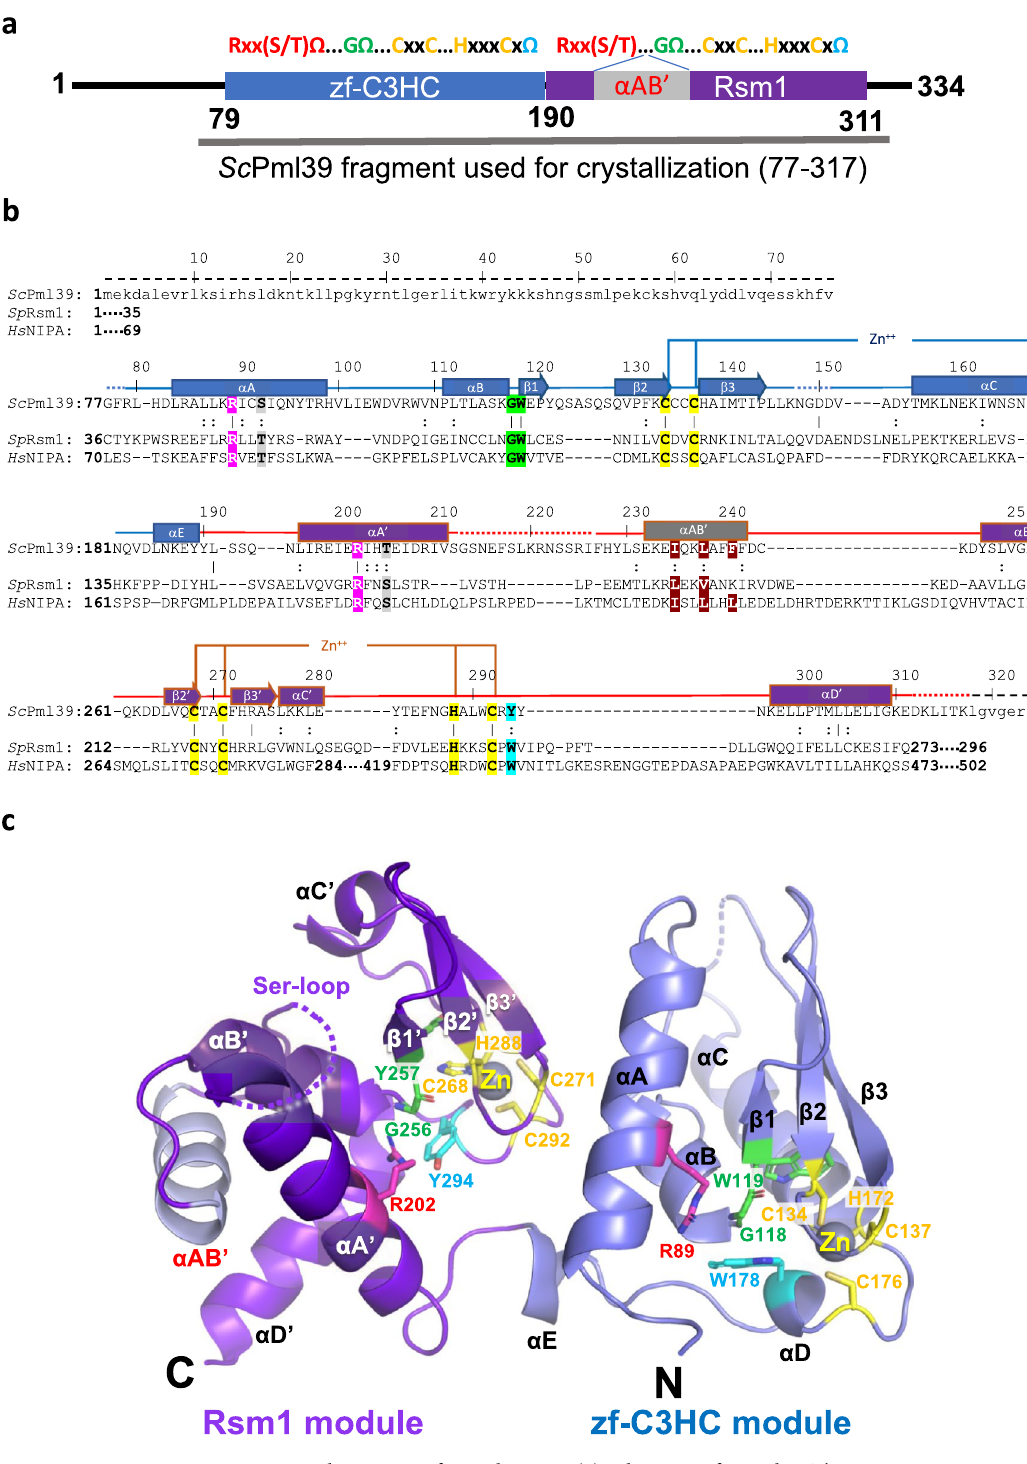
Figure 2. Crystal structure of Sc Pml39 77–317 . ( a ) Schematic of Sc Pml39. The consensus sequence of the zf-C3HC and Rsm1 modules is shown on the top. The zf-C3HC and Rsm1 modules are indicated in blue and purple, respectively. The fragment used for crystallization (residues 77–317) is shown. ( b ) Structure-guided sequence alignment of Sc Pml39, Sp Rsm1 and human NIPA/ZFC3HC1. αA–αE refer to α-helices, and β1–β3 to β-strands, indicating the secondary structure elements of Sc Pml39. Residue numbering is shown for Sc Pml39. Residues highlighted designate conserved Arg (magenta) and Ser/Thr (gray) in αA, Gly-aromatic residues between αB and β1 (green), conserved zinc-coordinating residues (yellow), a conserved aromatic residue in αD or in the loop αC’-αD’ (cyan), and conserved hydrophobic residues in αAB’ (brown). Similar and identical residues are marked as : and |, respectively. Disordered regions are represented by dotted lines, whereas regions lacking in the crystallization fragment are indicated by dashed lines and lowercase letters. ( c ) The Pml39 fold (cartoon representation) and side chains of key residues (stick representation) are